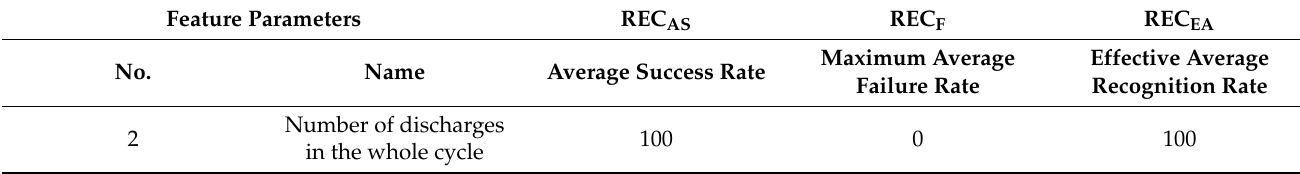
Table 13. GIS-3 best recognition rate: basic discharge parameters.